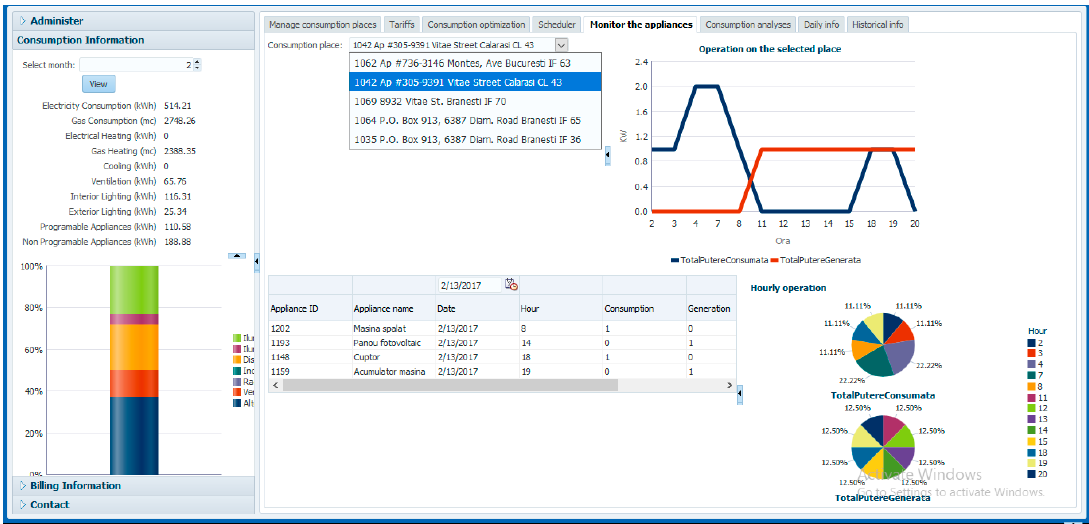
Figure 17. Appliances operation programming.